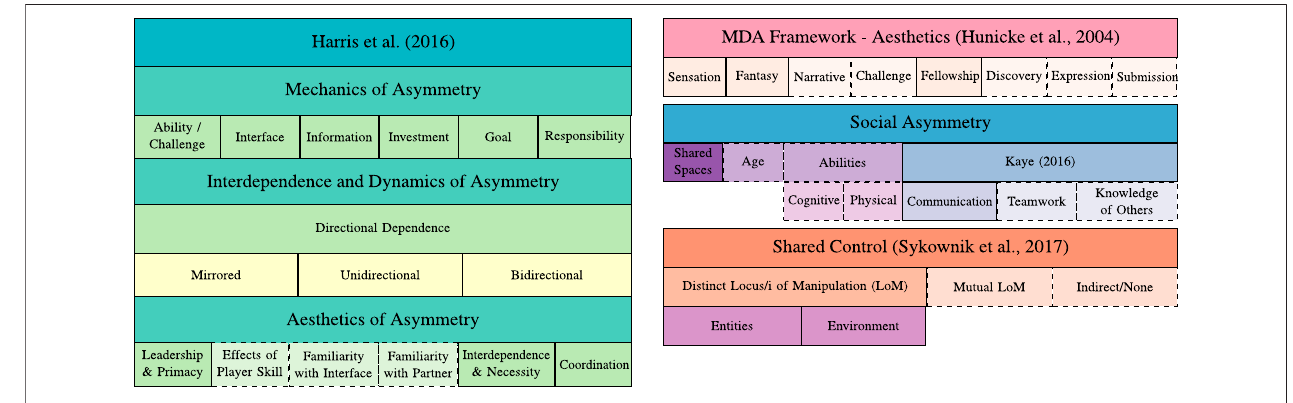
FIGURE 3 | Suggested post-hoc “ best fi t ” framework, with dashed lines and more transparent color for categories that are under-represented in existing asymmetric multiplayer VR games research so far.